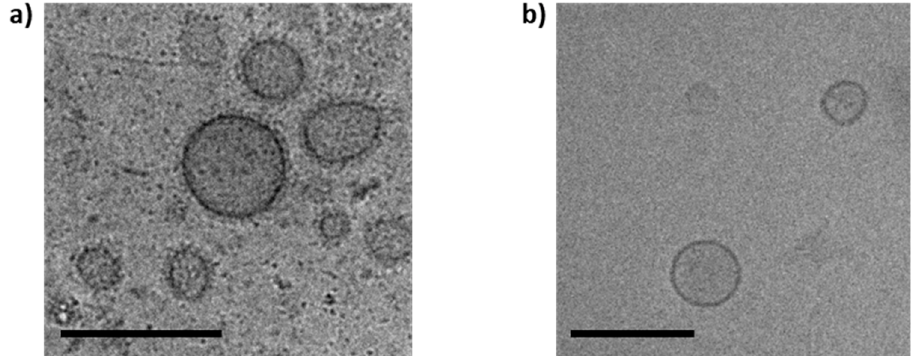
Figure 1. Cryo-TEM micrographs of ( a ) Cbfe23 outer membrane vesicles (OMVs) and ( b ) Cbv34 OMVs. Both OMVs are spherical and about 150 nm in size. Scale bars = 200 nm.